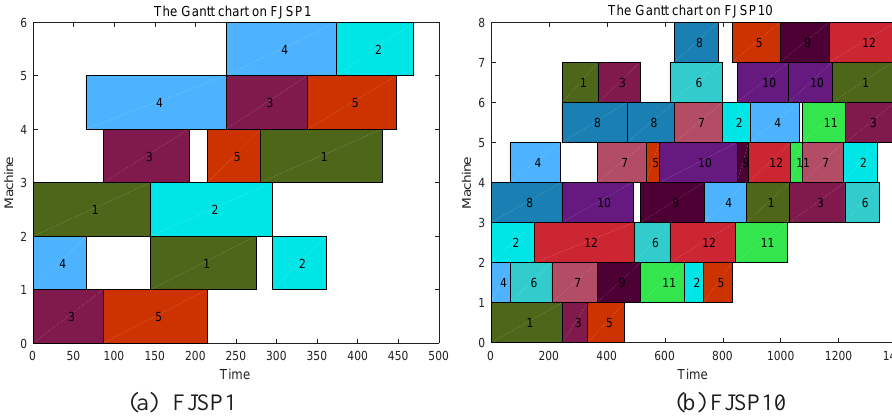
Fig. 3. The Gantt chart on FJSP1 and FJSP10 by our